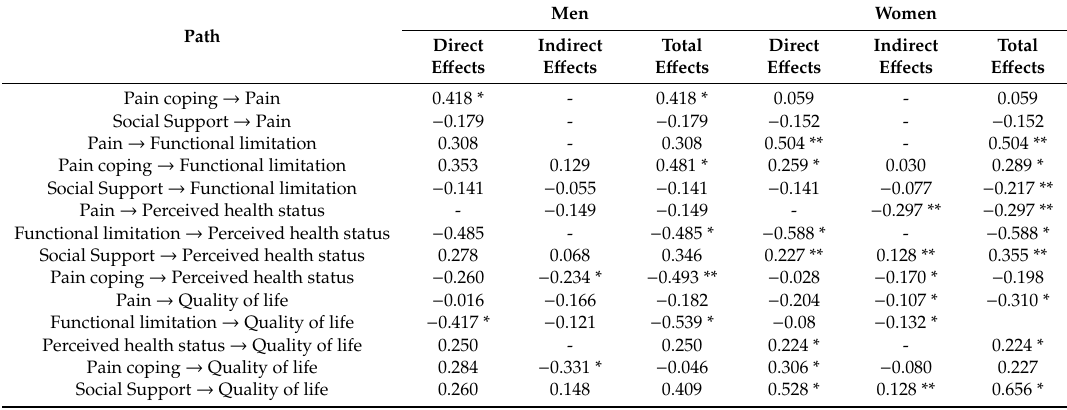
Table 5. Standardized direct, indirect, and total e ff ects of variables on quality of life.